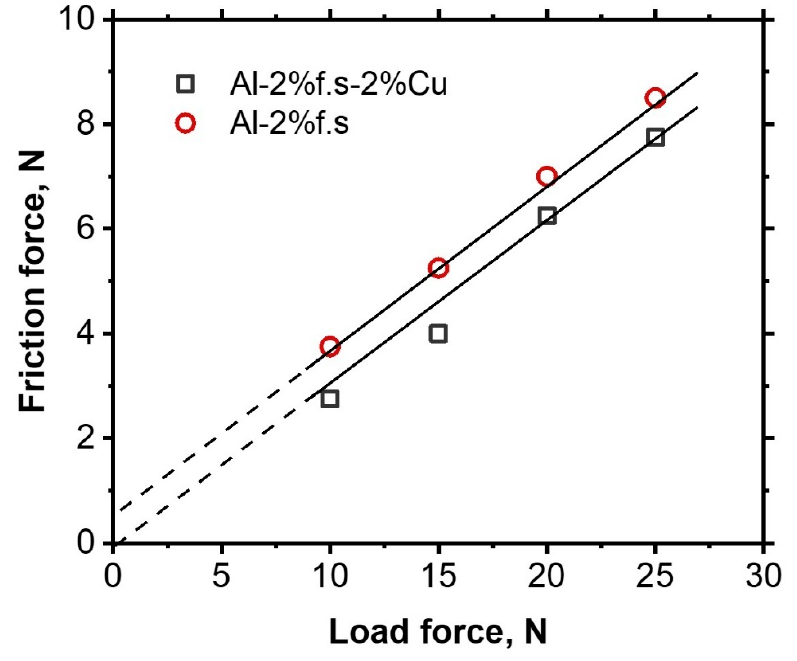
Figure 7. The dependence of friction force on an applied load at a sliding speed of 0.12 m/s for Al-2%f.s and Al-2%f.s-2%Cu.